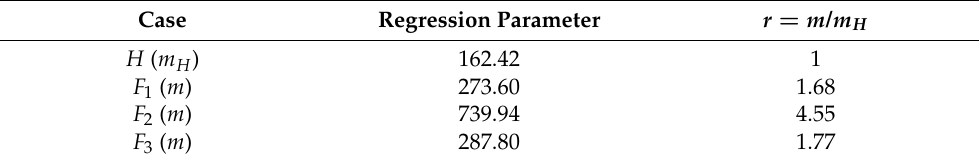
Figure 10. Data fusion profile: H (blue), F 1 (red), F 2 (orange), and F 3 (green). In this case, the fault detection is clear for F 2 faulty scenario. Table 6. Third numerical experiment